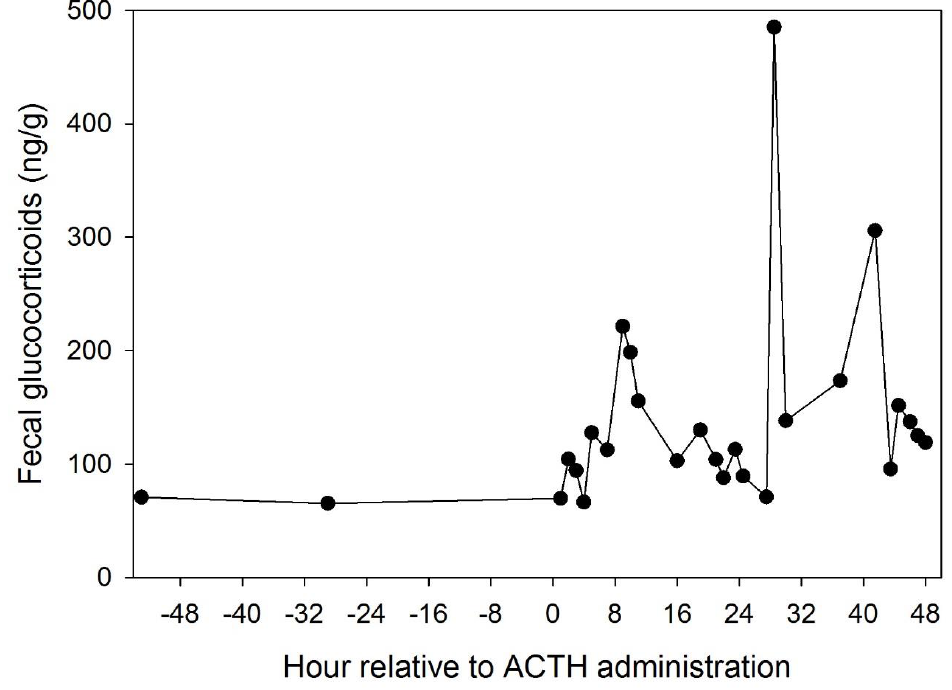
Figure 1. Fecal glucocorticoid profile of a male guinea pig before and after administration of adrenocorticotropic hormone (ACTH; Day 0). The maximum fecal glucocorticoid concentration was detected 28.5 h after intramuscular administration of 20 IU synthetic ACTH; concentrations returned to pre-injection levels after 43